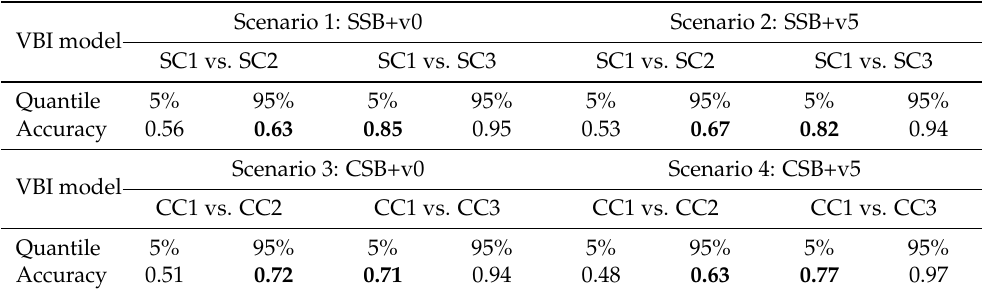
Table 9. Quantiles of accuracy values using SAE.